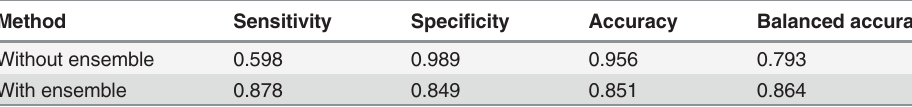
Table 4. Prediction results with or without the ensemble